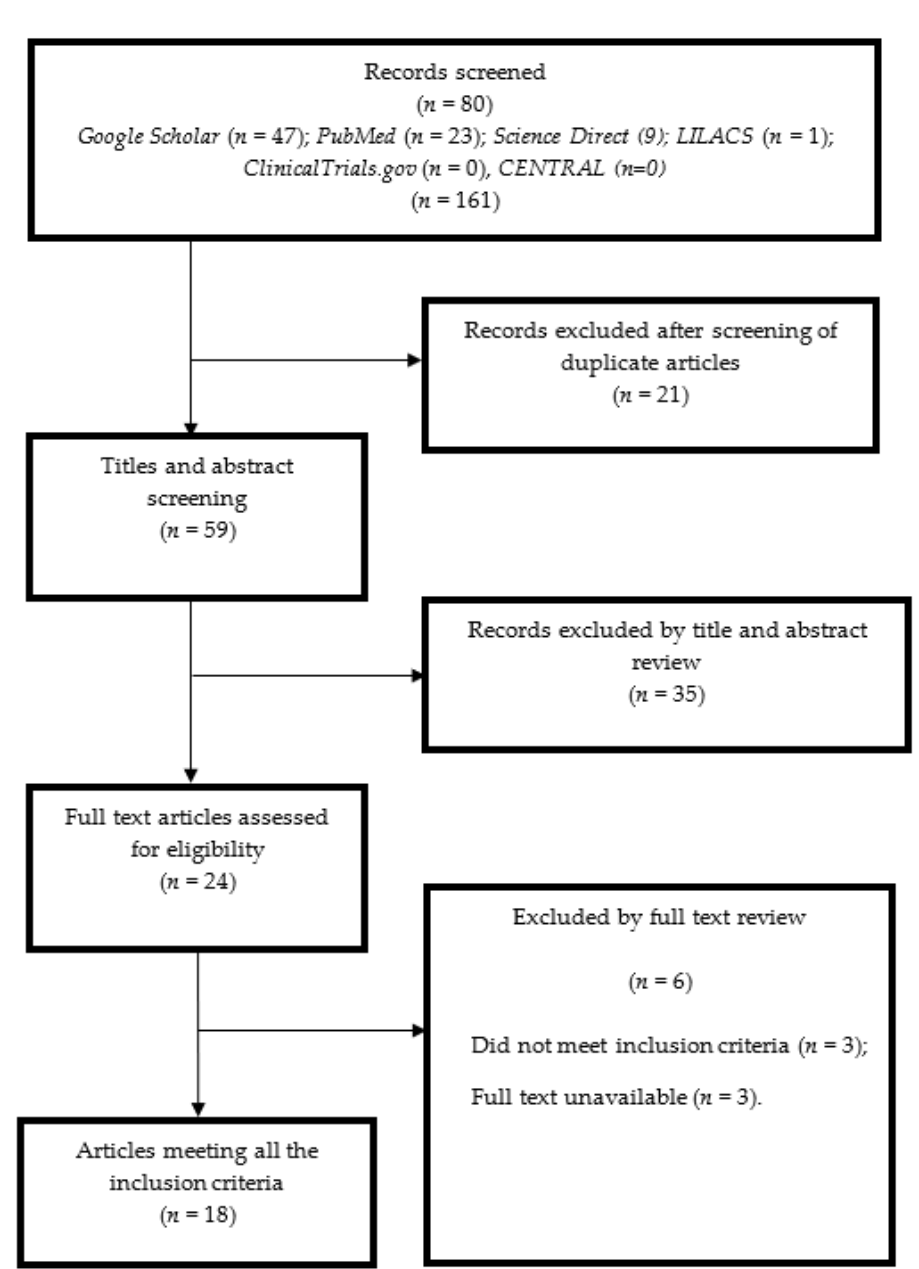
Figure 1. Preferred Reporting Items for Systematic reviews and Meta-Analyses.